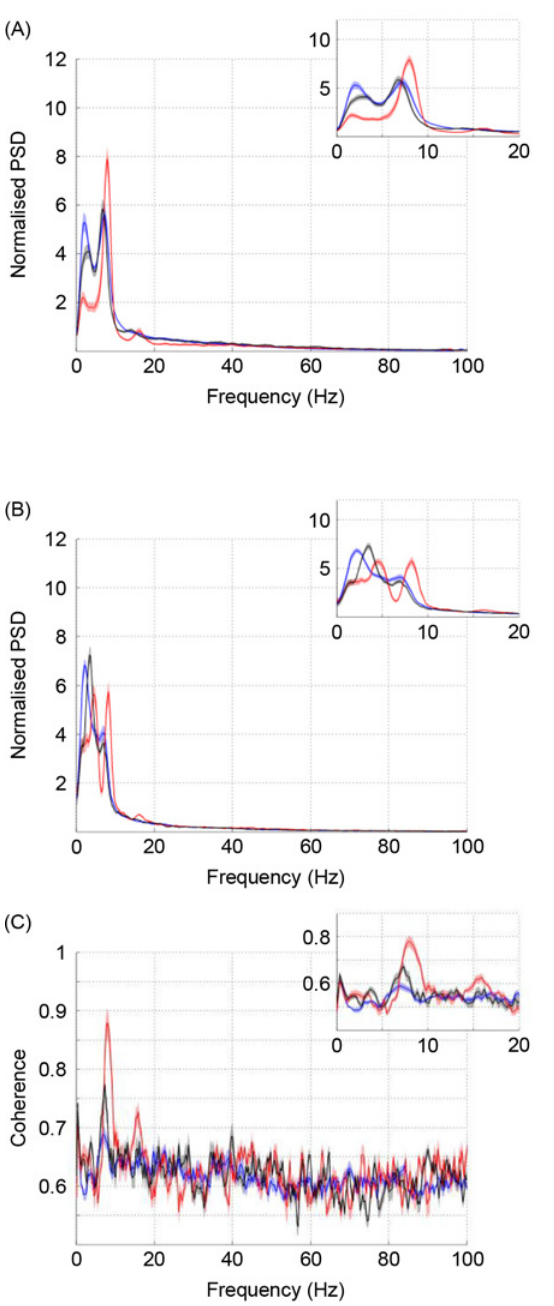
Fig 6. Power spectral density and coherence at different task phases. Power-spectral density (PSD) is shown for the dCA1 (A) and striatum (B), along with the coherence between these two regions (C). The traces shown are: pre-maze (blue), water-maze (red) and platform (black), ± SEM. A magnified signal (0 – 20 Hz) is shown in the inset. Notably, theta-frequency PSD and coherence are both elevated inside the water-maze environment. Coherence is also elevated for rats on the maze platform, albeit to lesser